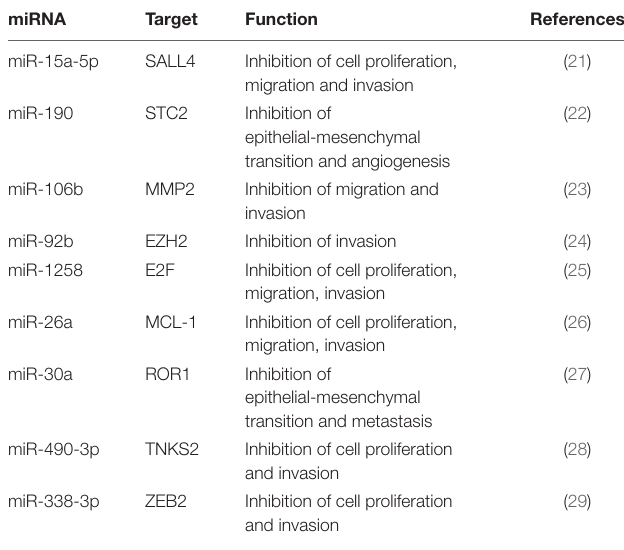
TABLE 1 | Tumor suppressor